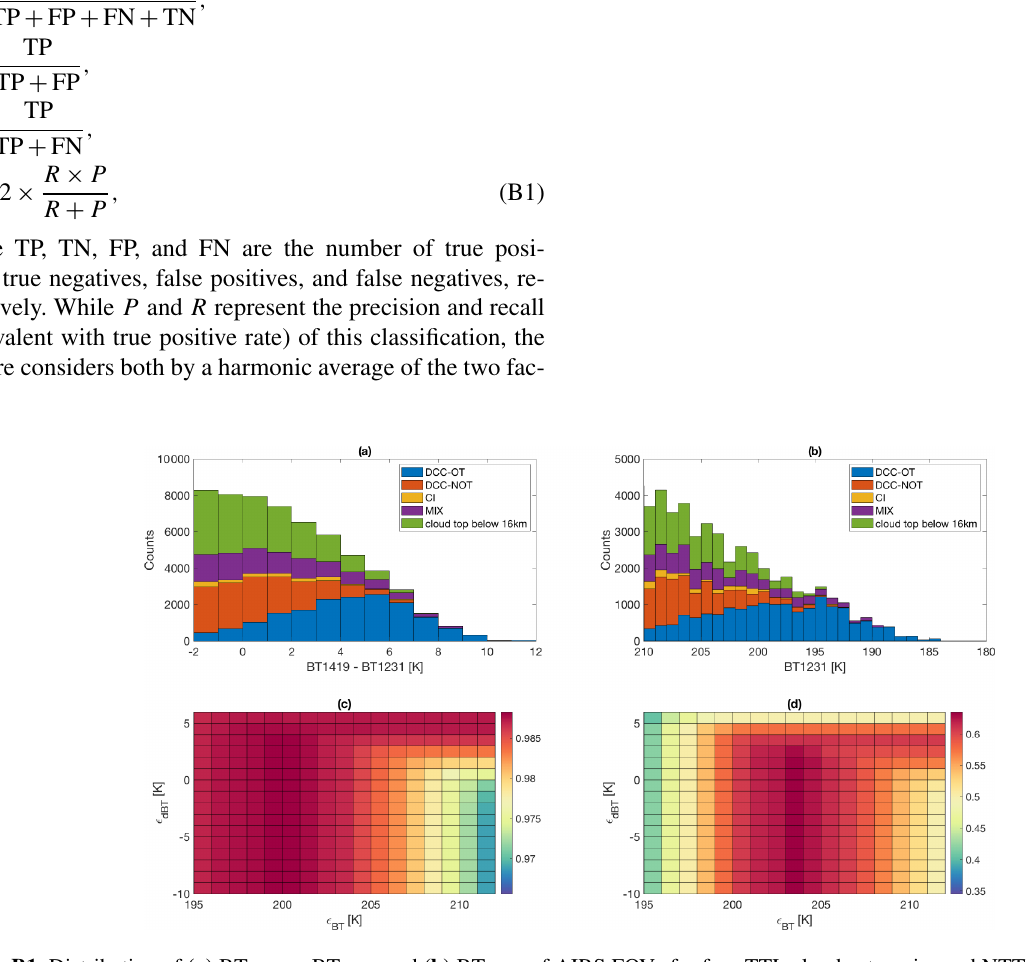
Figure B1. Distribution of (a) BT 1419 − BT 1231 and (b) BT 1231 of AIRS FOVs for four TTL cloud categories and NTTL (cloud top below 16km). (c) The accuracy (Eq. B1, α ) and (d) F score ( F 1 ) of the DCC-OT classification using the BT 1231 ≤ ε BT and BT 1419 − BT 1231 ≥ ε (cid:49) BT